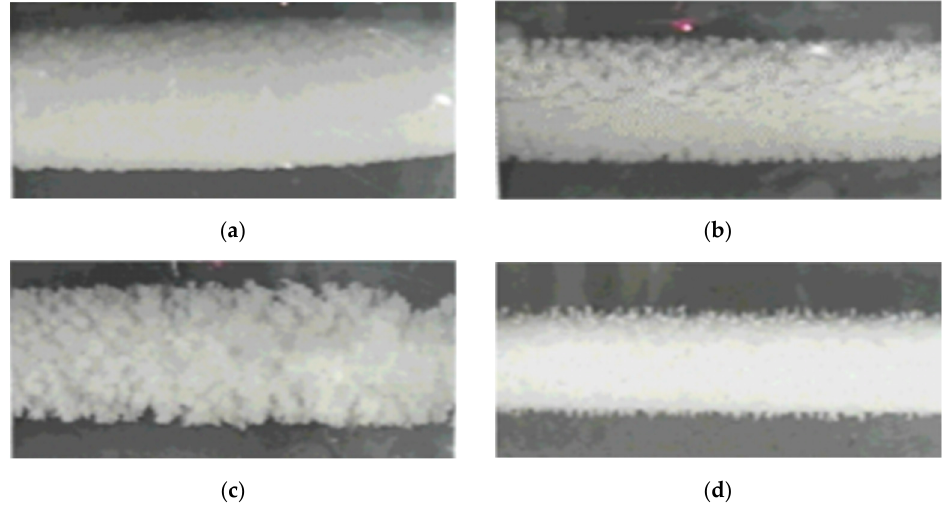
Figure 6. Accreted icing at different electric fields of conductors. ( a ) 0 kV/cm. ( b ) AC 15 kV/cm. ( c ) DC + 15 kV/cm. ( d ) DC − 15 kV/cm.